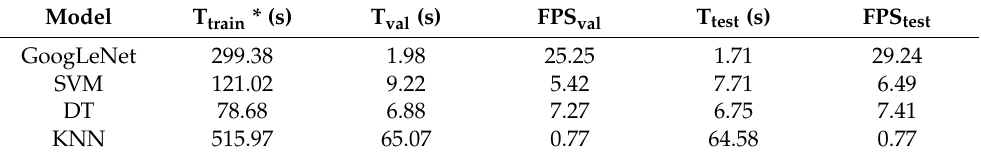
Table 7. Assessment results of computational time of the GoogLeNet and three other ML models. Model T train *